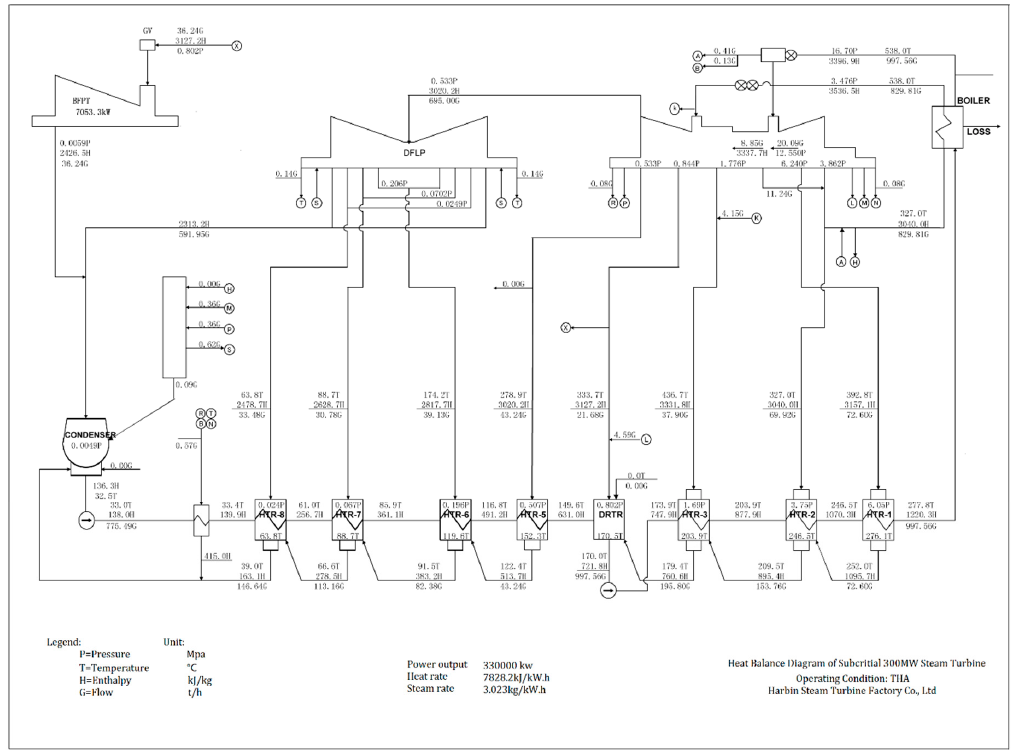
Figure A1. Heat balance diagram in turbine heat acceptance (THA) condition. Energies 2018 , 11 , x FOR PEER REVIEW